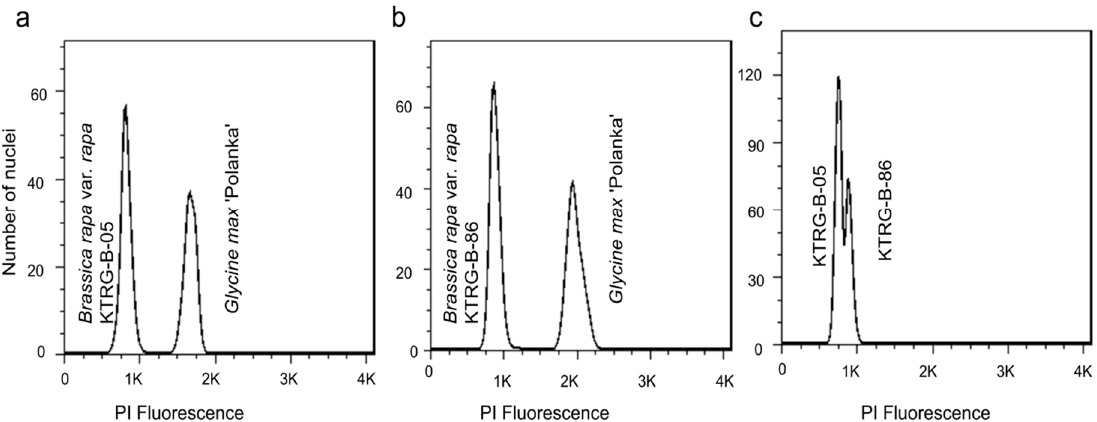
Figure 3. Histograms of flow cytometric data represent genome size estimation of landrace from KTRG-B-05 ( a ) and KTRG-B-86 ( b ) in internal standardization with Glycine max ‘Polanka’. Co-chopping of landraces showed differences in genome size ( c ).